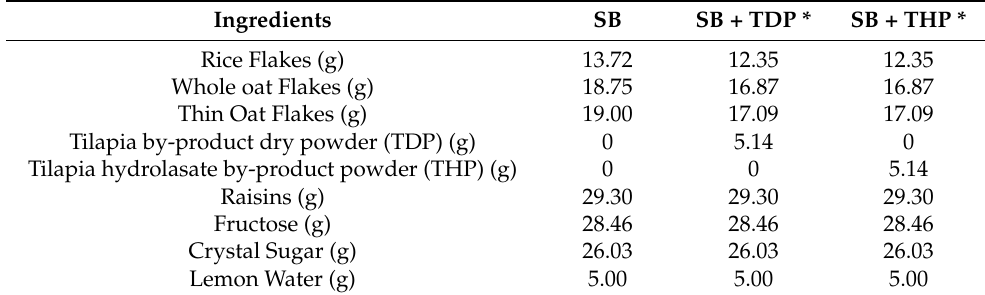
Table 1. Formulation of snack